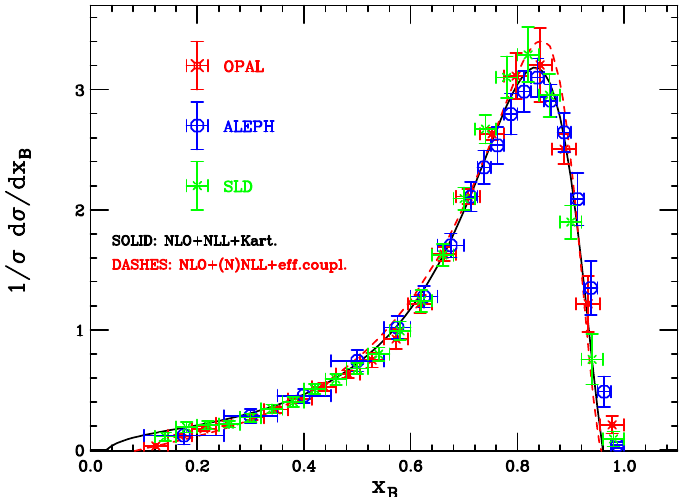
Table 1. Experimental Mellin moments of the B -hadron cross section from the DELPHI collabora- tion, along with the model yielded by the calculation in [20], based on an effective coupling constant, the perturbative moments at NLO+NLL as in Ref. [6] and the extracted N -space non-perturbative fragmentation function.